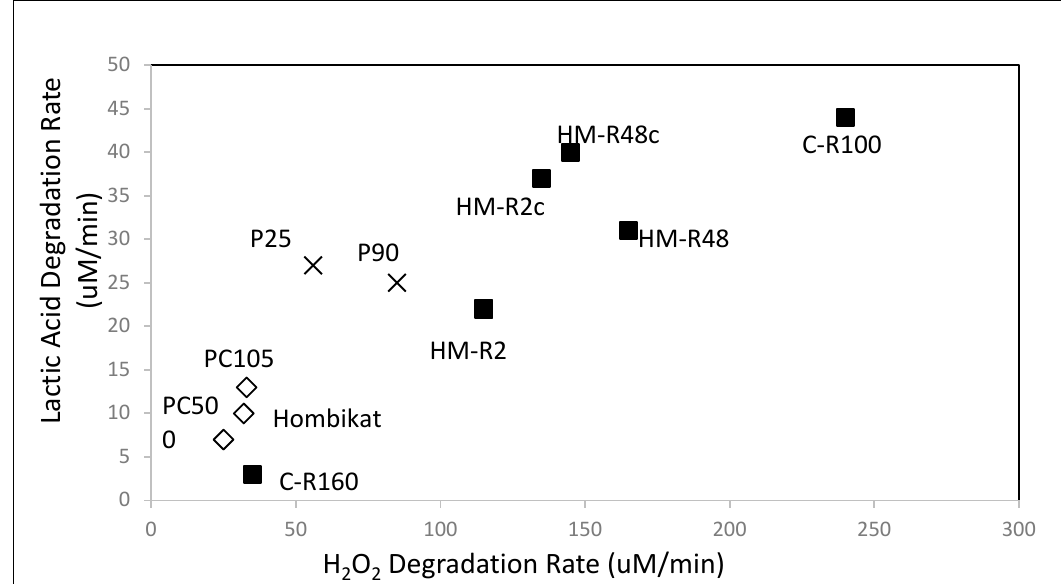
Figure 5. Lactic acid degradation rate as a function of H 2 O 2 degradation rate for various TiO 2 samples.